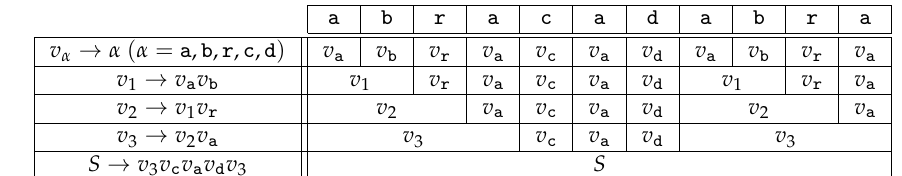
Figure 1. An example of the grammar generation process of RePair for the text abracadabra . The generated grammar is